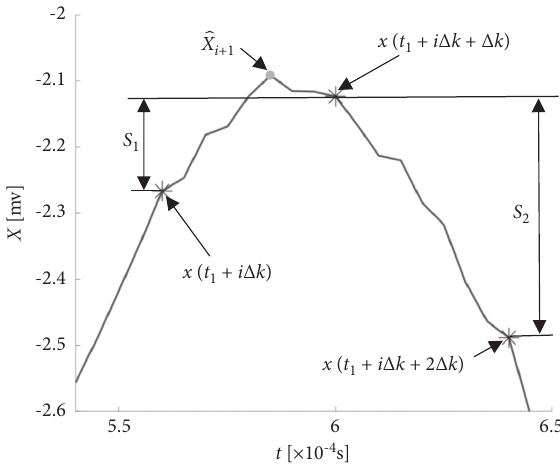
Figure 23: vibration angle vs. time of the propeller shaft.